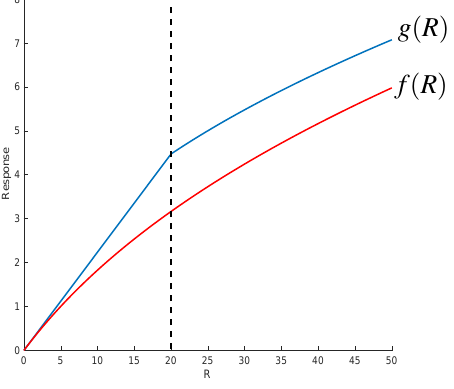
Fig. 1 Response functions g ( R ) and f ( R ) of population R for the parameters a 2 = 1, (cid:101) h = 20 and a 1 = 1 √